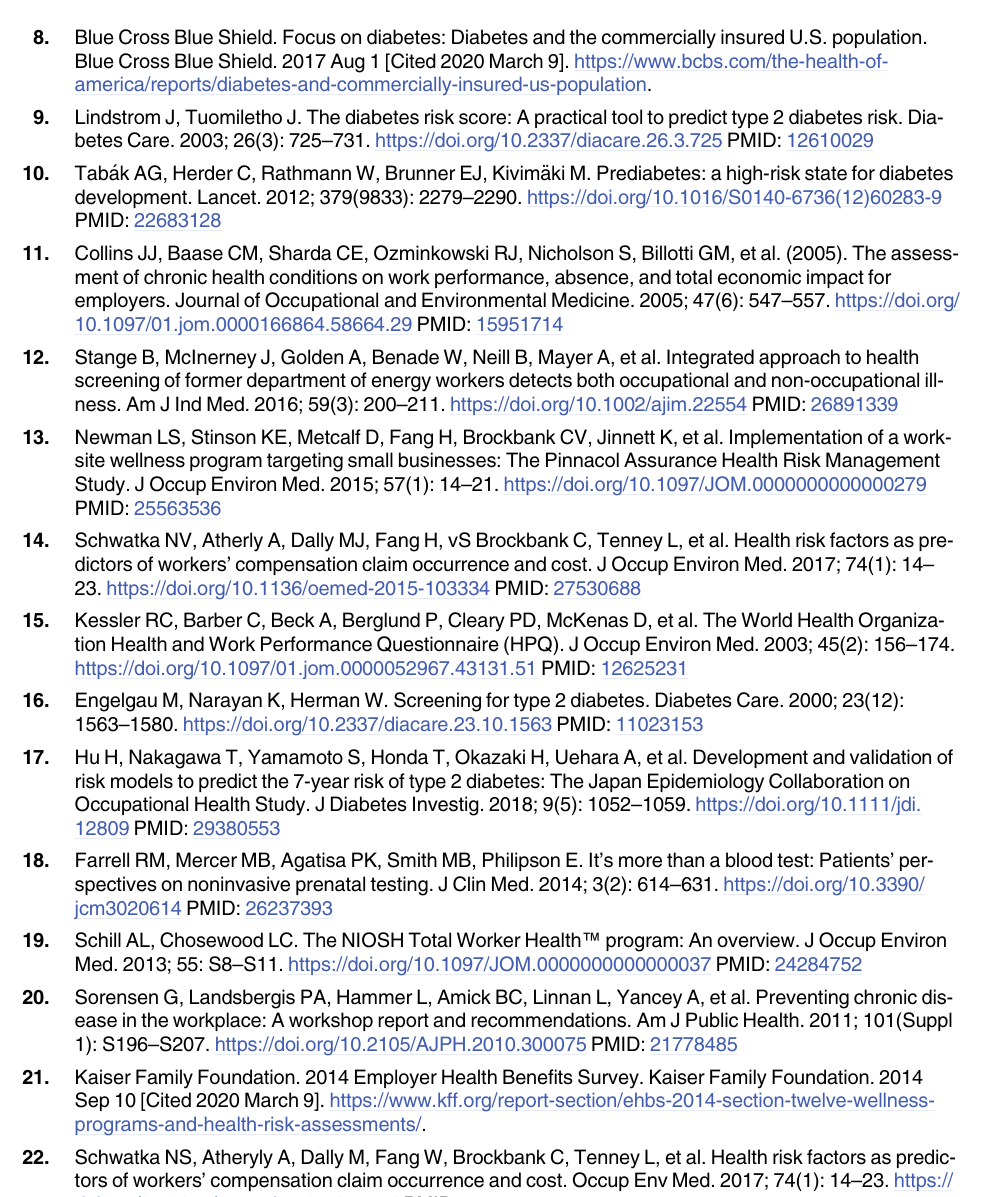
8. Blue Cross Blue Shield. Focus on diabetes:Diabetesand the commercially insured U.S. population. Blue Cross Blue Shield. 2017 Aug 1 [Cited 2020 March 9]. https://www.bcbs.com/the-health-of-